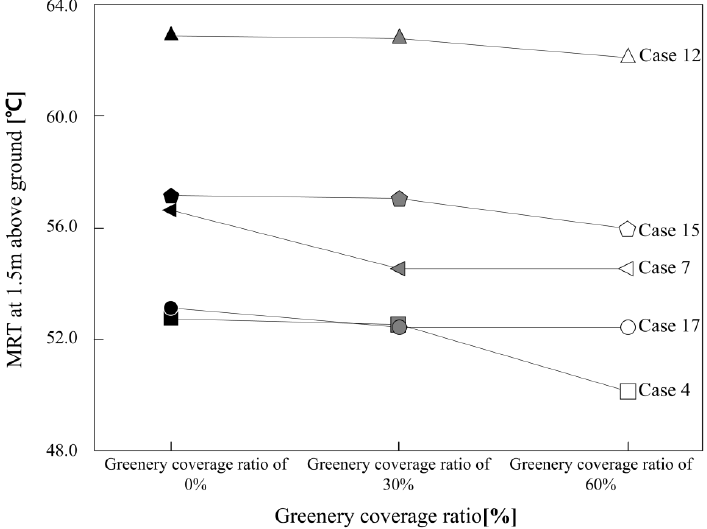
Figure 7. Mean Radiant Temperature (MRT) according to the change of the greenery coverage